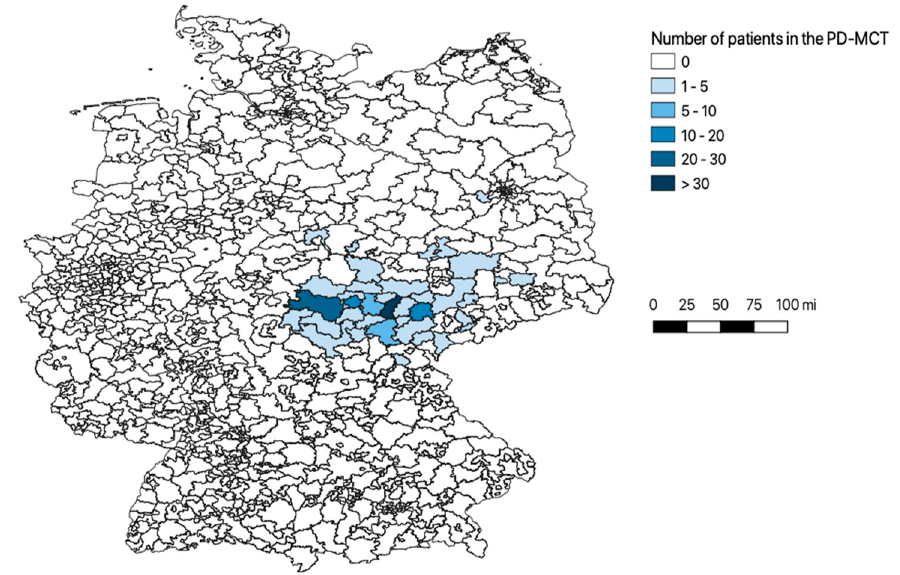
Figure 1. Study population, catchment area (zip code). The figure shows a map of Germany divided by zip code as the catchment area; the color coding represents the number of patients treated in the PD-MCT at our neurology ward in 2019. PD-MCT: Parkinson’s disease multimodal complex treat- ment. Table 1. Study population, baseline characteristics.